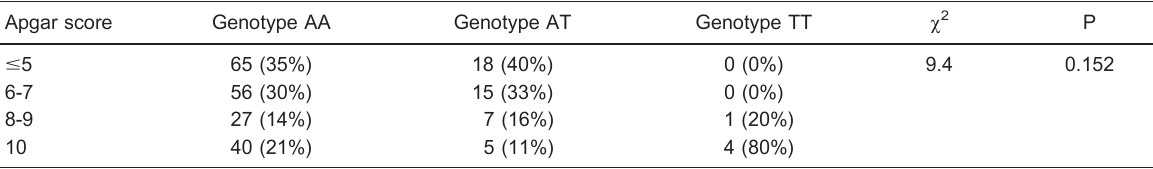
Table 3. Genotype distribution analysis of NOS3 gene polymorphism rs3918186 and Apgar score. Apgar